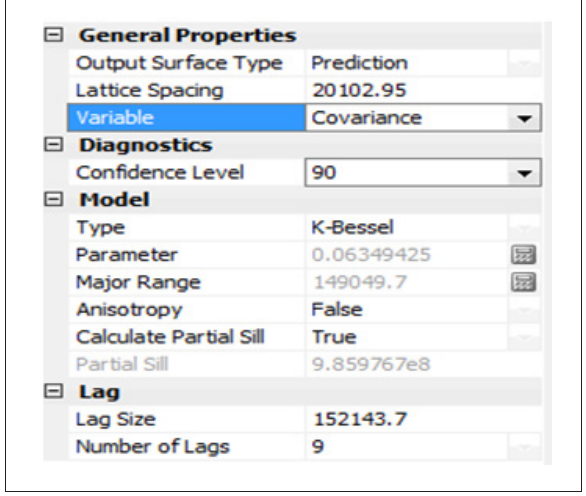
Figure 3: Components of the variogram stage of areal interpolation adap- ted from ArcGIS.